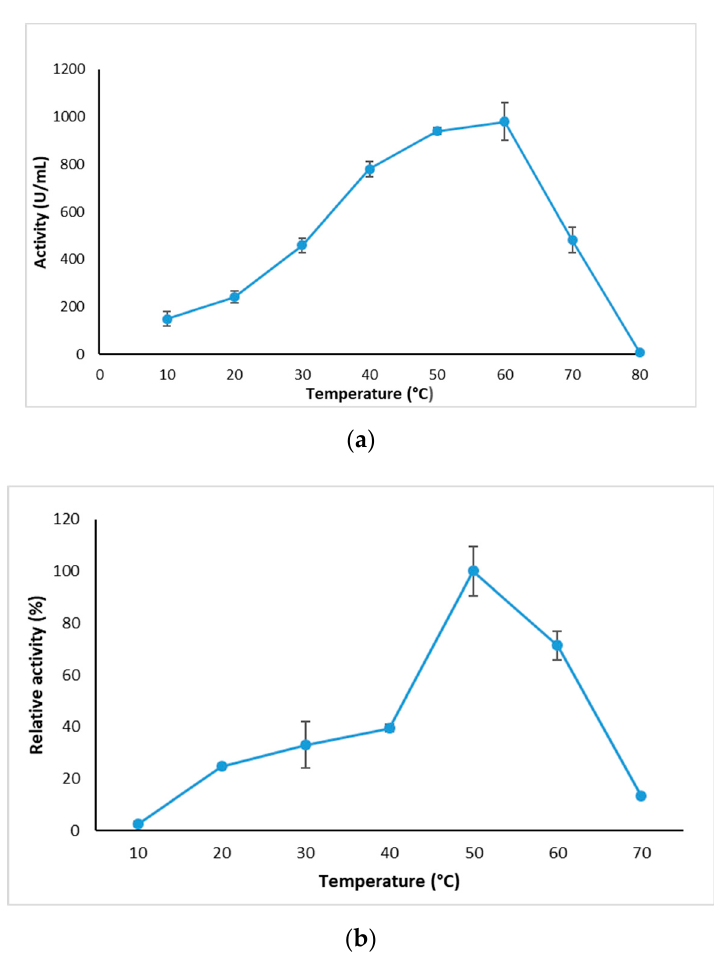
Figure 4. Effect of temperature on enzyme ( a ) activity and ( b ) stability of purified GlaEst12. The optimal temperature was determined by measuring the enzymatic activity at different temperatures ranged from 10–70 °C by using C10 as a substrate. The maximum optimal activity was observed at 60 °C. The temperature stability of purified esterase was determined by measuring the residual activities after the enzyme had been incubated for 30 min at different temperatures (10–80 °C) and the assay was performed at optimum temperature. Error bar represents standard deviation ( n = 3). The absence of the bar indicates the error smaller than symbols.